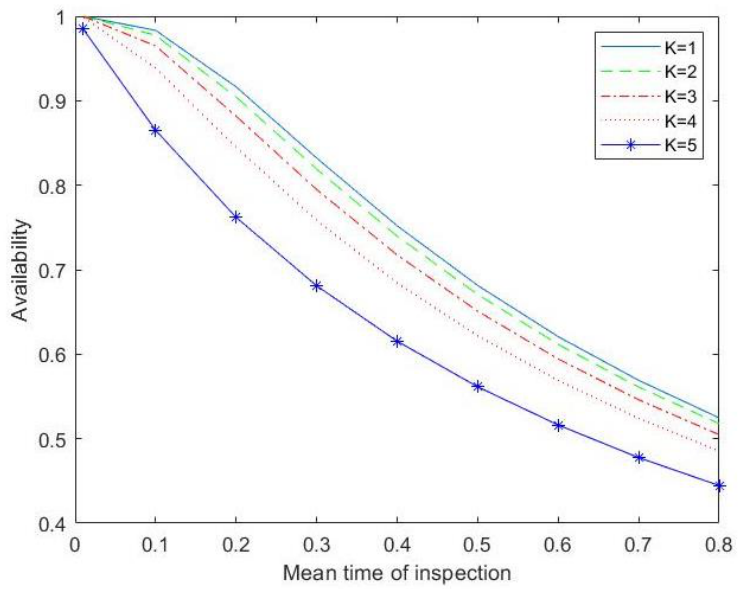
Figure 8. Availability in terms of the mean time between inspections for different values of K